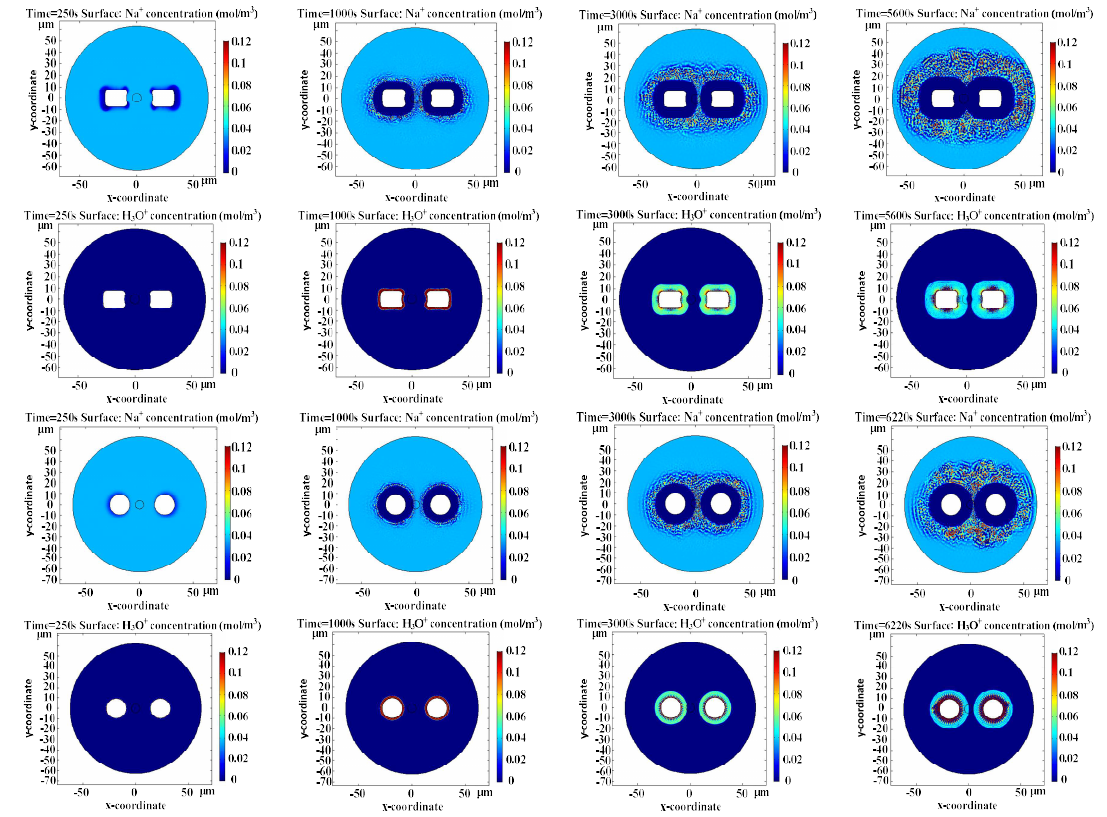
Figure 3. Concentration distribution of Na + and H 3 O + in cross section of the optical fibers F1 (first two rows) and F2 (last two rows) with both electrodes biased at positive high-voltage at different poling times.